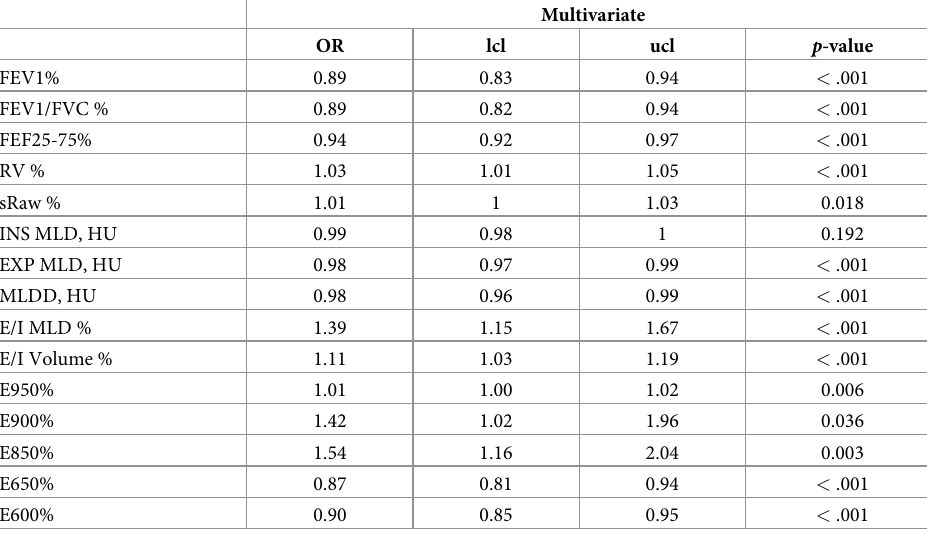
Table 3. Multivariate logistic regression of LDIs for diagnosis